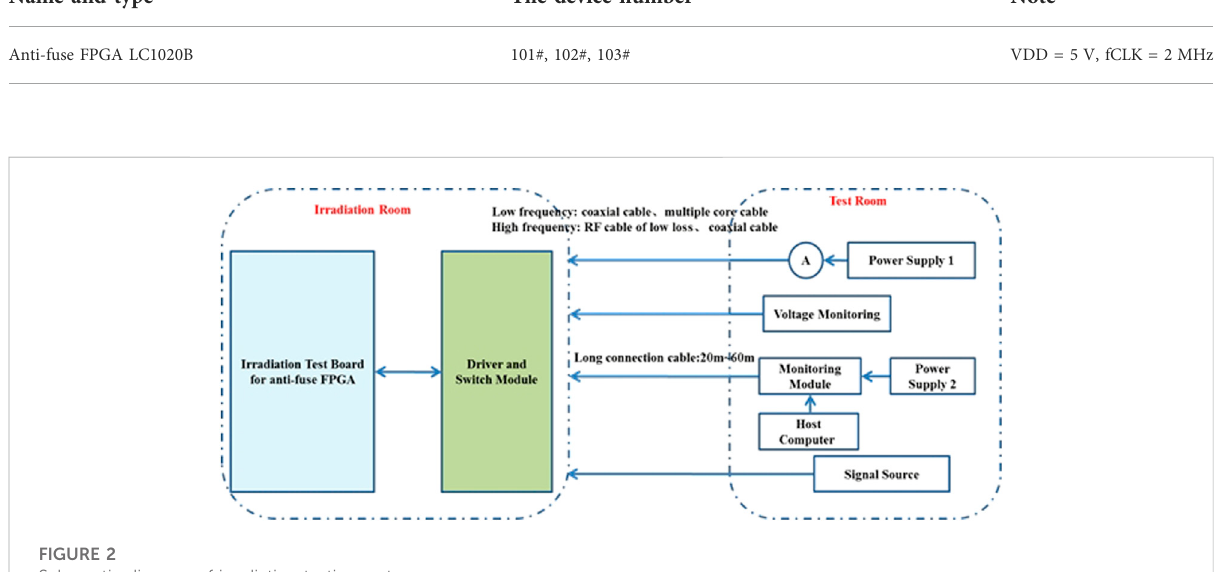
FIGURE 2 Schematic diagram of irradiation testing system.